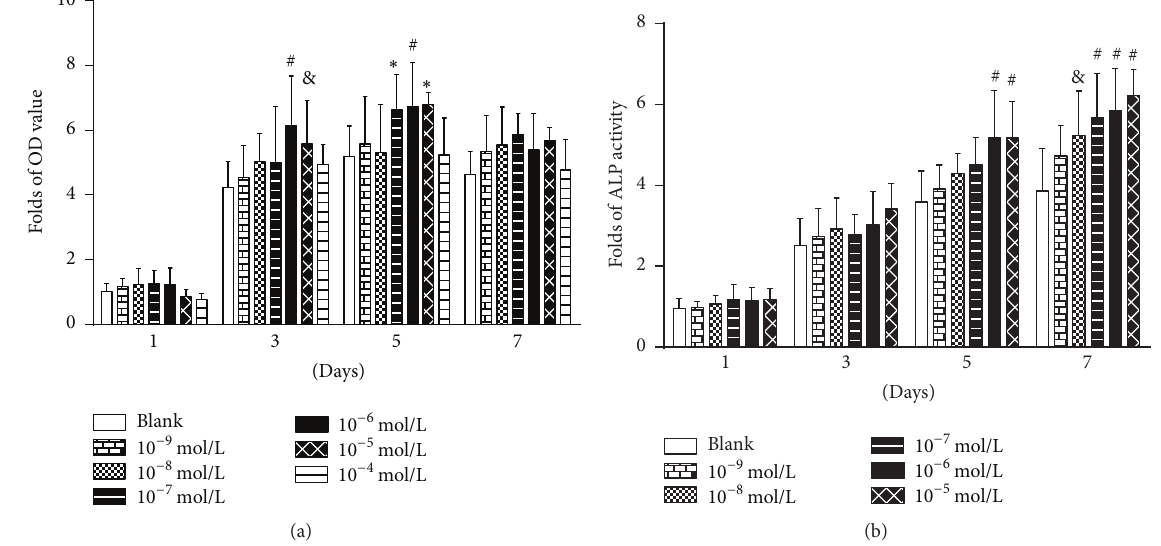
Figure 2: Time-course and dose-dependent tests to select the optimal concentration of icariin for inducing the osteogenic differentiation of BMSCs. Icariin of 0, 10 −9 , 10 −8 , 10 −7 , 10 −6 , 10 −5 , or 10 −4 mol/L was used to treat preosteoblasts for 1 day, 3 days, 5 days, and 7 days. (a) Cell proliferation assays; (b) alkaline phosphatase (ALP) activity assays. All data are presented as mean values together with the standard deviation (SD). ∗ 𝑝 < 0.05 ; & 𝑝 < 0.01 ; # 𝑝 < 0.001 indicating the statistical difference between the indicated group and the control group (blank) at the same time